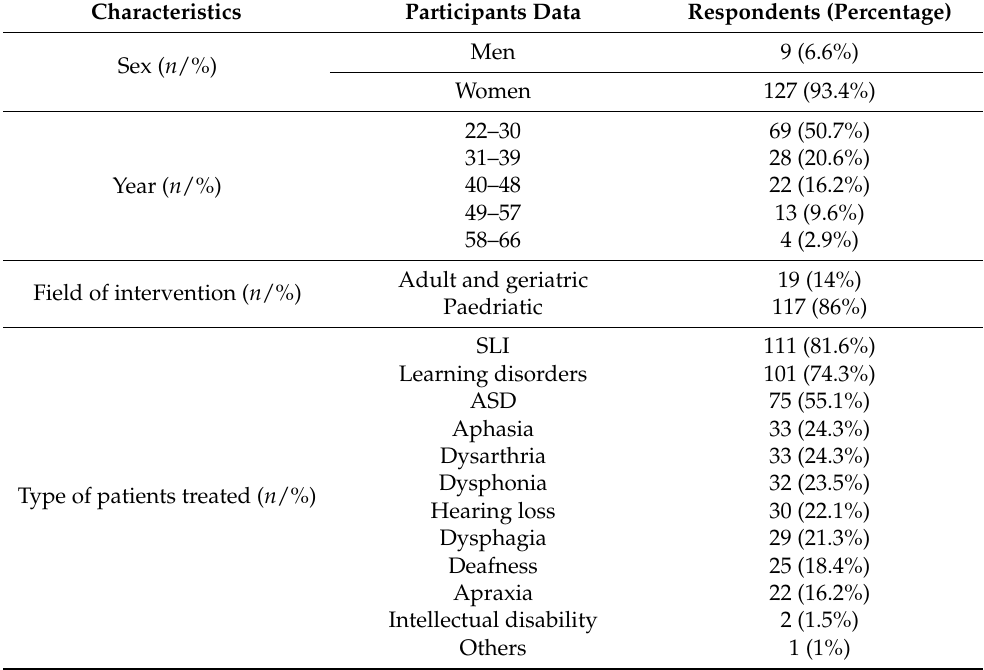
Table 1. Demographic characteristics of the SLTs.